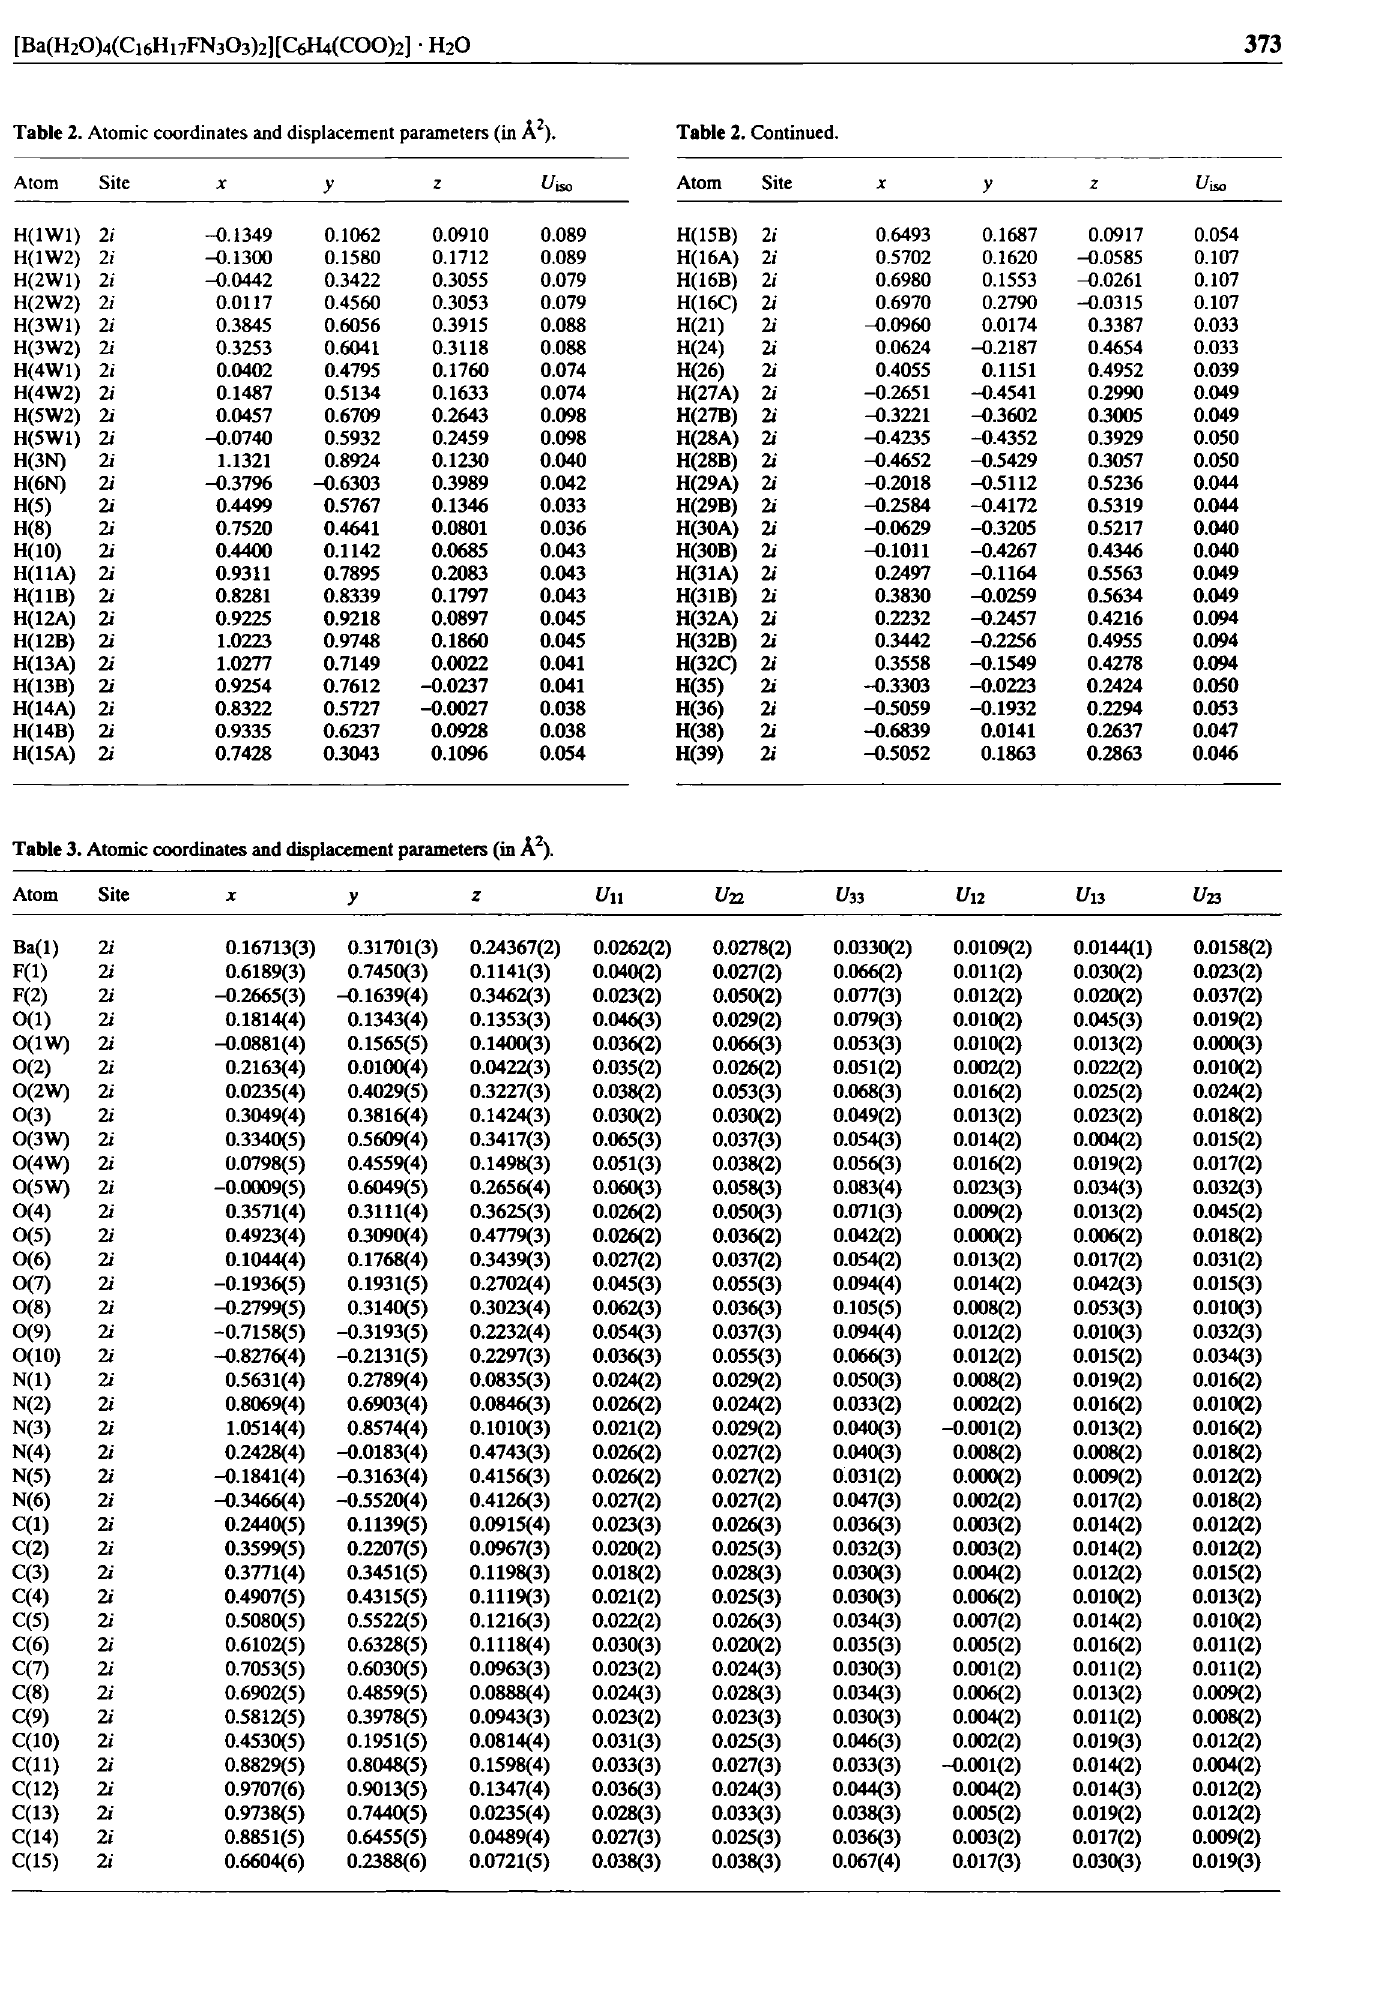
Table 3. Atomic coordinates and displacement parameters (in A 2